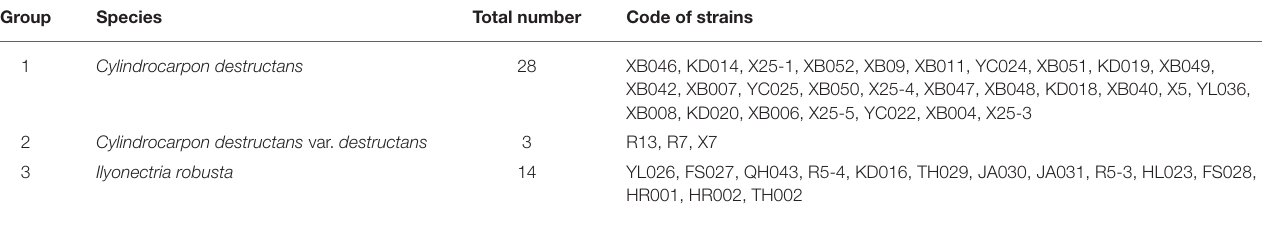
TABLE 2 | Classification of 45 Cylindrocarpon isolates with rDNA-internal transcribed spacer (ITS) sequence analysis. Group